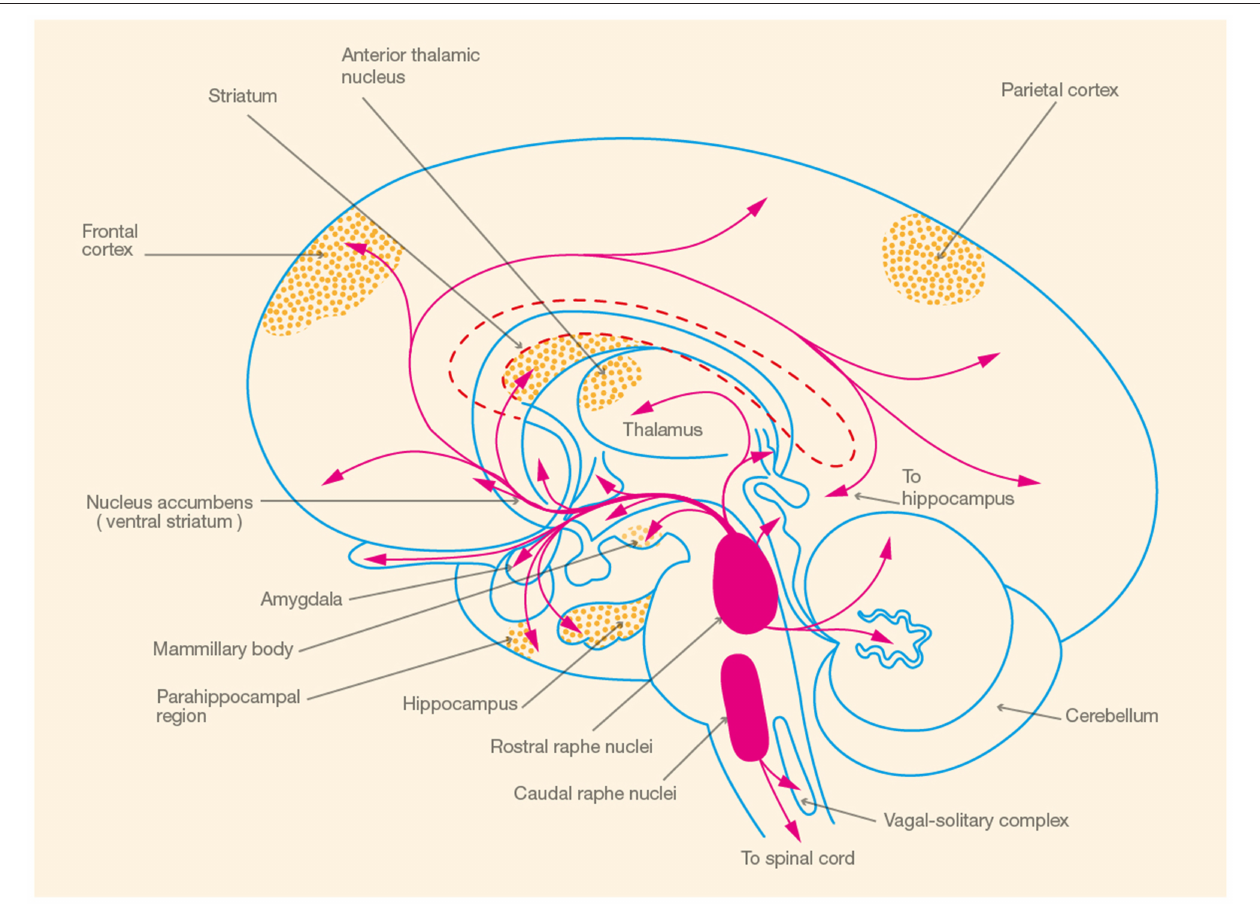
FIGURE 1 | Schematic illustration of brain areas involved in spatial memory ( ) and the corresponding serotonergic pathways ( ) (Adapted from Heimer, 1994, p. 227).